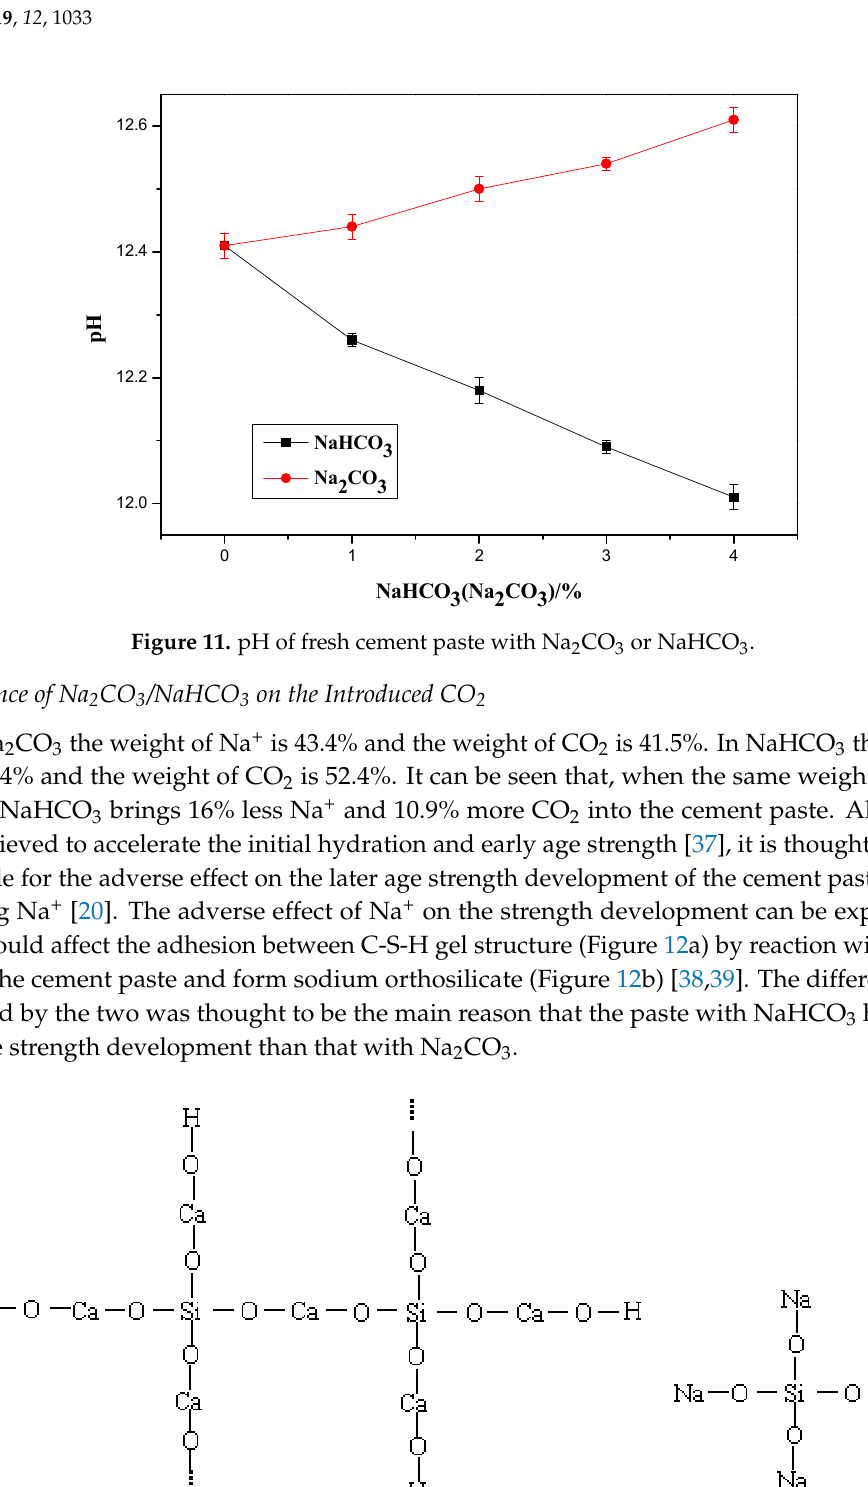
Figure 12. Sketch of the structure of C-S-H gel ( a ) and sodium orthosilicate ( b ).